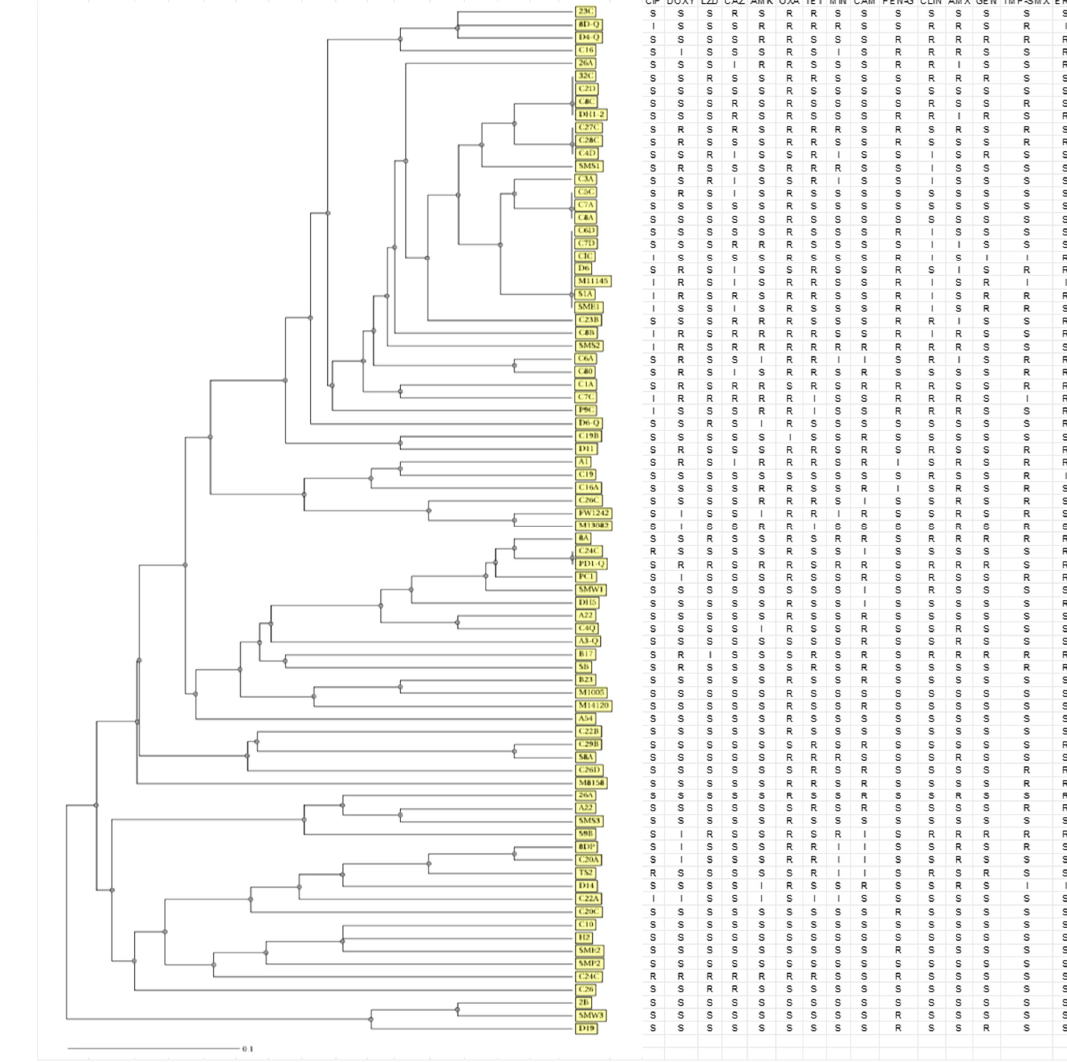
Detection of Resistance